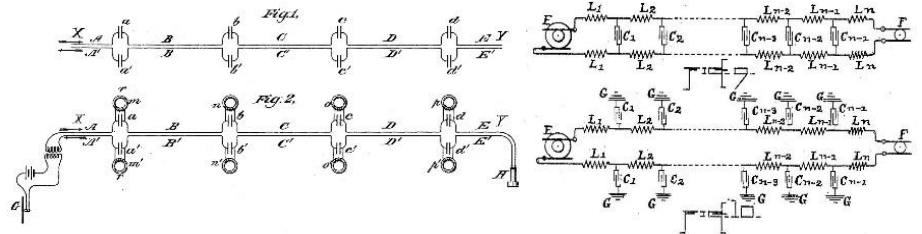
Fig. 6. The inclusion of load coils in a telephone line according to Pupin's patents US519346 (left) and US652231 (right).